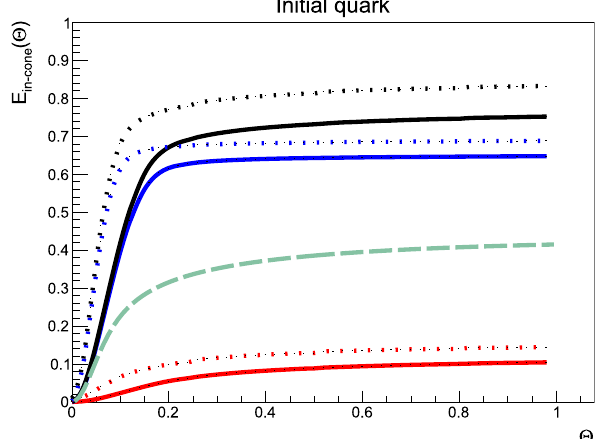
Fig. 10 Energy in cone for an initial gluon jet (left) and for an ini- tial quark jet (right) after 4fm in the case of k T -dependent branching + l 2 ) ] (solid lines), Gaussian approximation in and w( l ) ∝ 1 / [ l 2 ( m 2 D